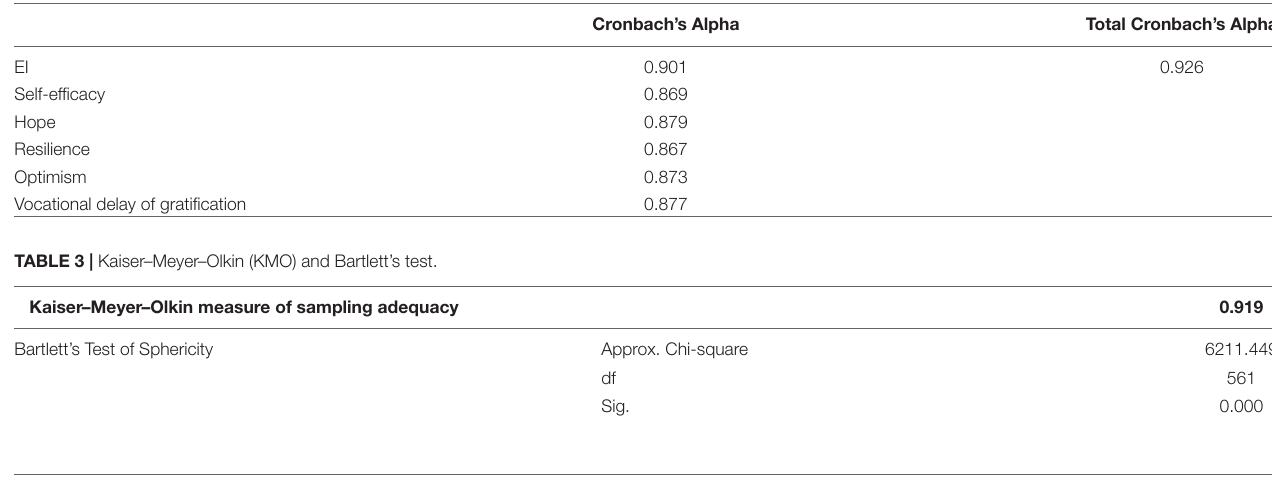
TABLE 2 | Reliability analysis of the questionnaire.